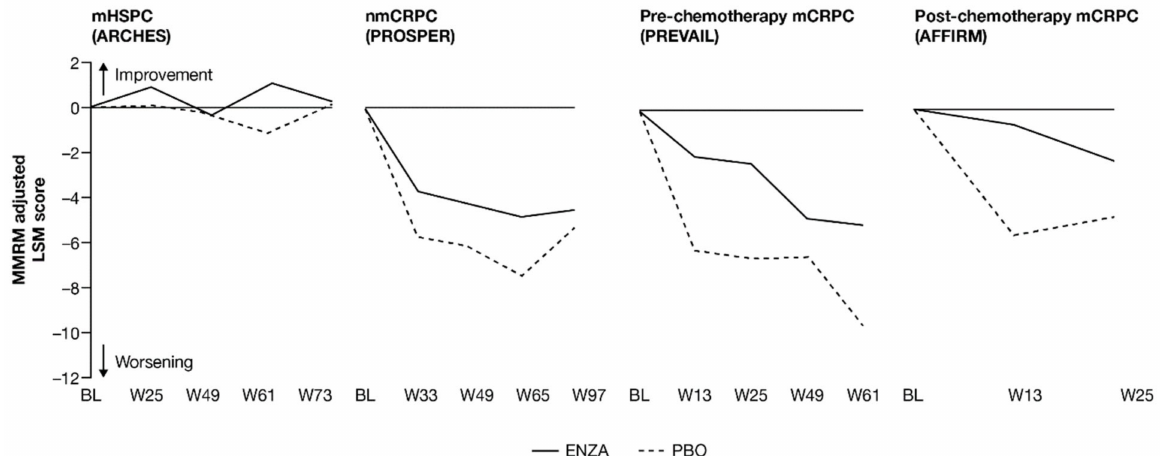
Figure 6. Adjusted and unadjusted change from BL in VAS score. ENZA indicated by solid line, and control group indicated by dashed line. For AFFIRM, EQ-5D-5L VAS was only collected at weeks 13 and 25. Abbreviations: BL: Baseline; ENZA: Enzalutamide; EQ-5D-5L: EuroQol 5-Dimension 5-Level questionnaire; LSM: Least squares mean; mCRPC: Metastatic castration-resistant prostate cancer; mHSPC: Metastatic hormone-sensitive prostate cancer; MMRM: Mixed-model repeated measure; nmCRPC: Non-metastatic castration-resistant prostate cancer; PBO: Placebo, VAS: Visual Analog Scale; W: Week.